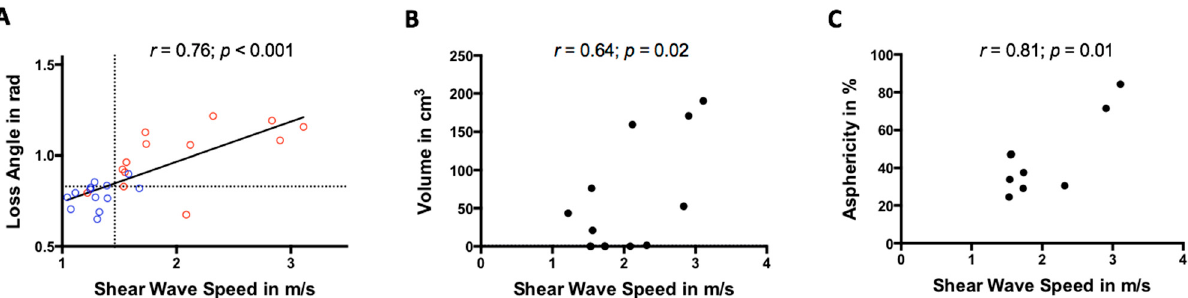
Figure 4. Scatter plot showing a positive correlation between shear wave speed (in m/s) and ( A ) loss angle of the complex shear modulus (cutoffs that differentiate between tumorous and nontumorous areas in participants with pancreatic neuroendocrine tumors are indicated by dashed lines; pancreatic neuroendocrine tumor = red, healthy control = blue), ( B ) tumor volume (in cm 3 ), and ( C ) positron emission tomography-based asphericity (in%). Table 2. Parameters.